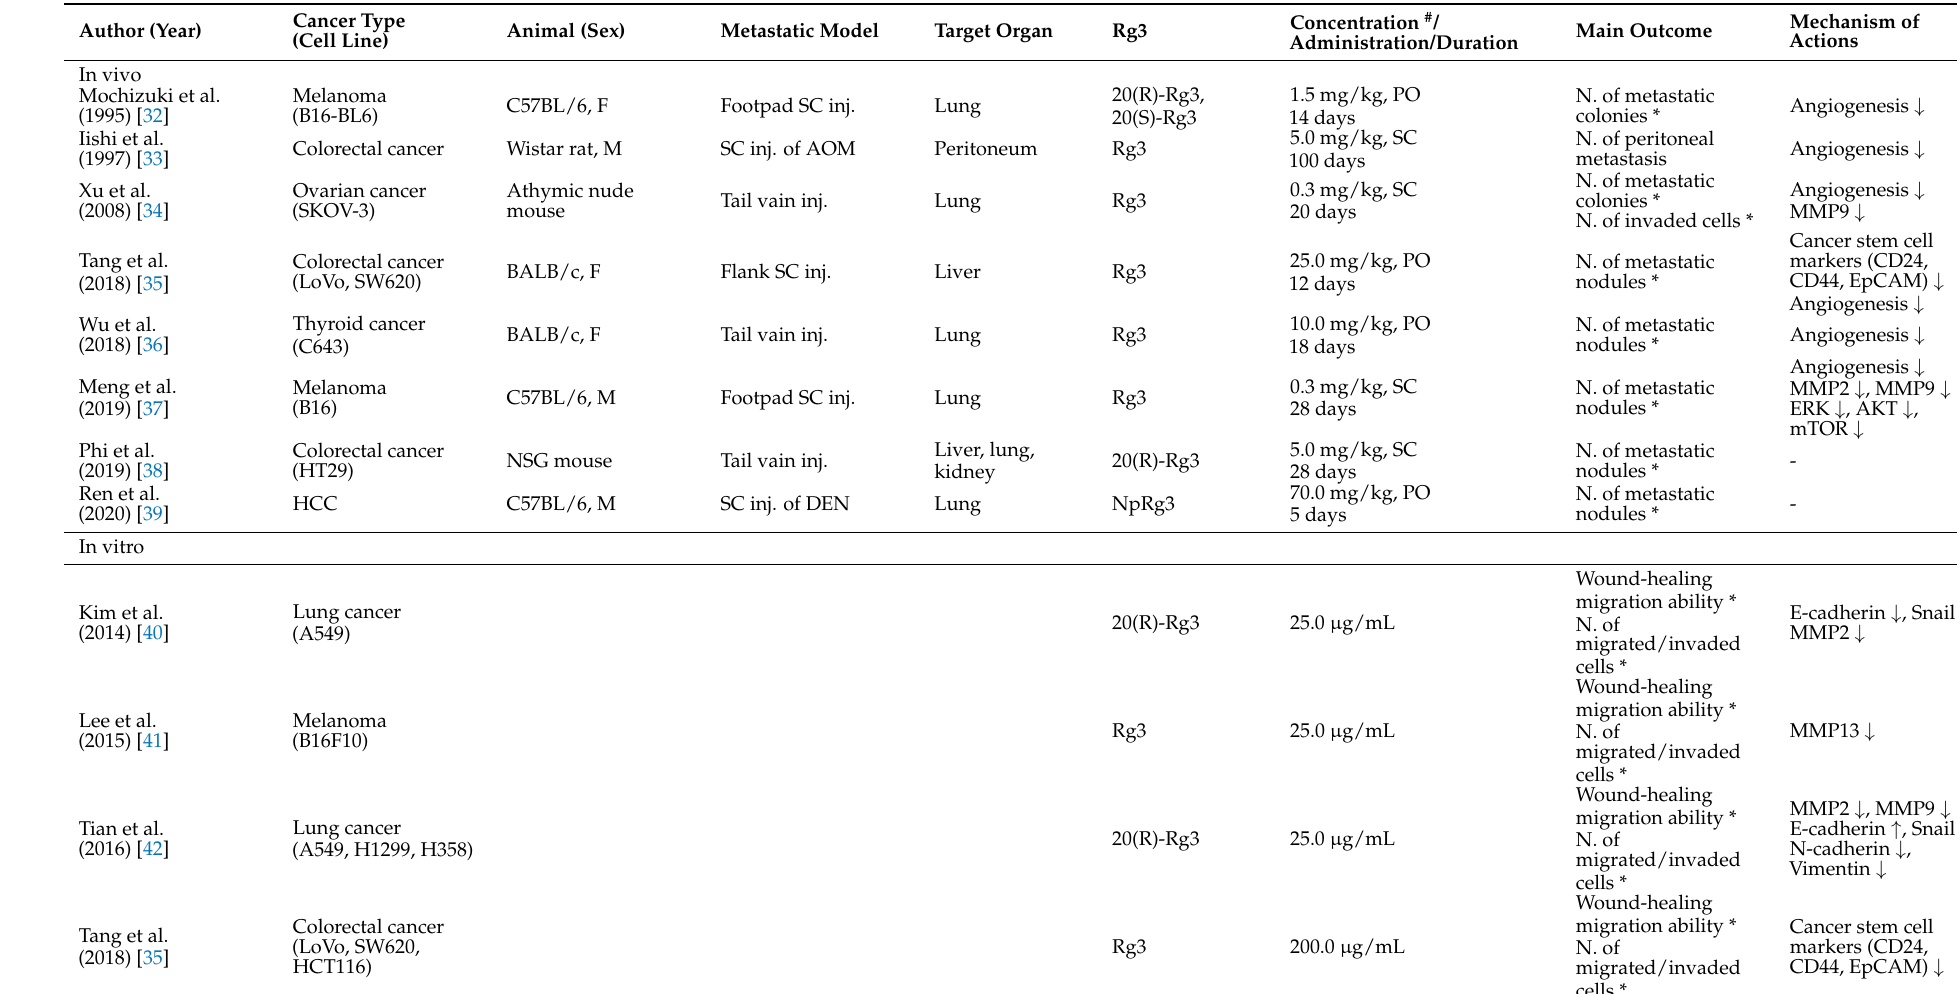
Table 2. Summary of 14 studies on anti-metastatic effects of ginsenoside